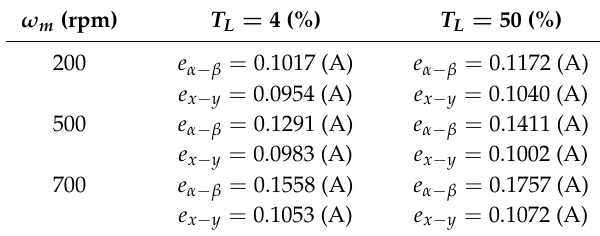
Table 4. Experimental results for the proposed min-max PSCC for different speeds and